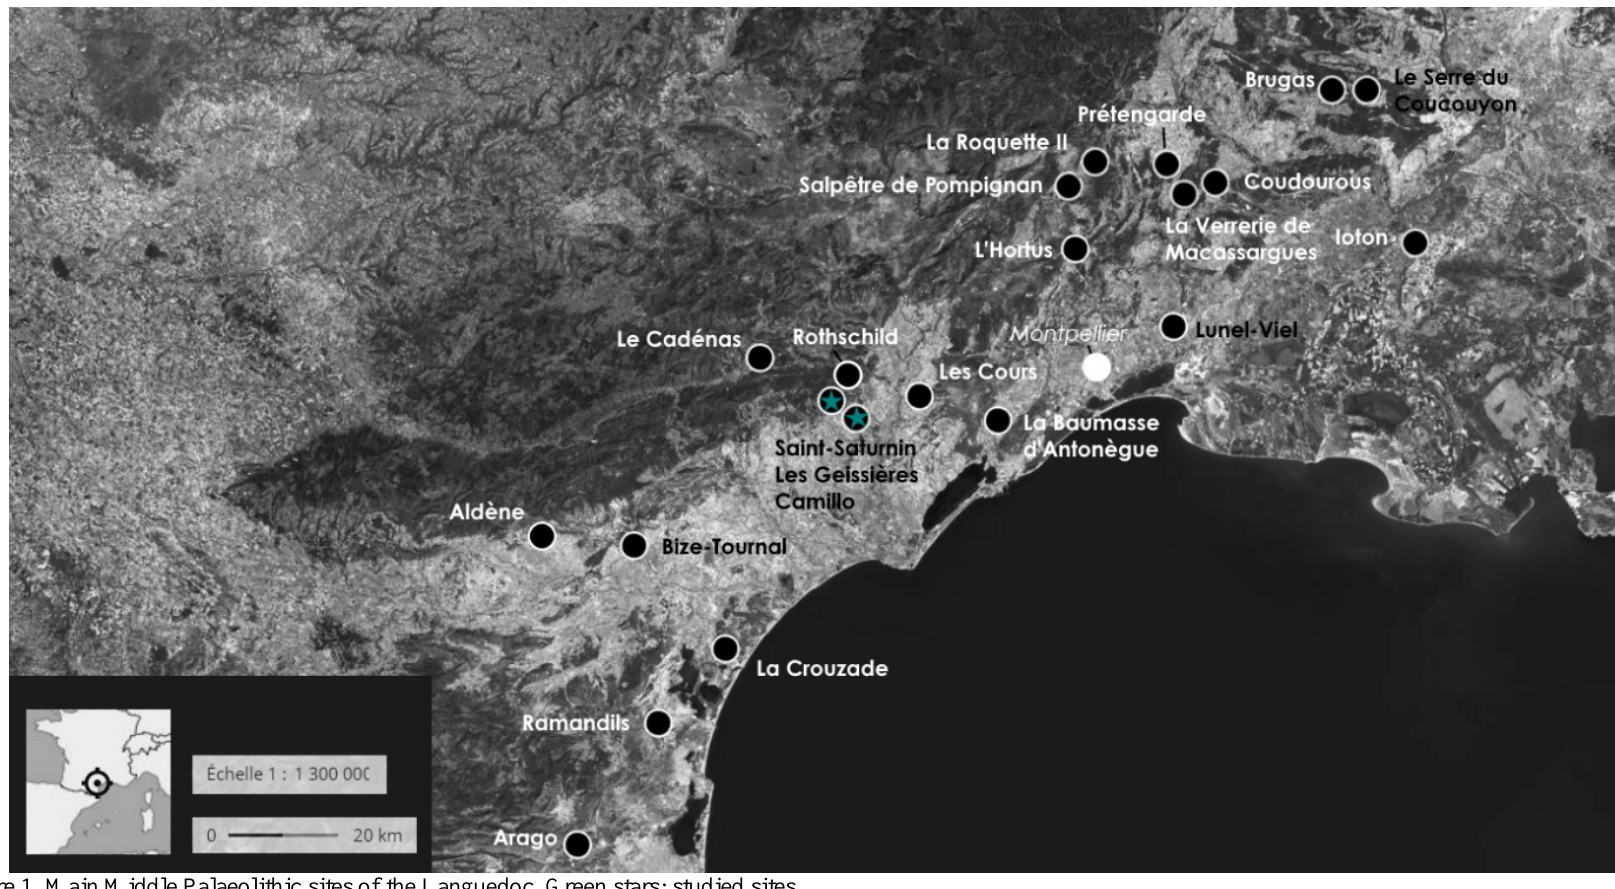
Figure 1. Main Middle Palaeolithic sites of the Languedoc. Green stars: studied